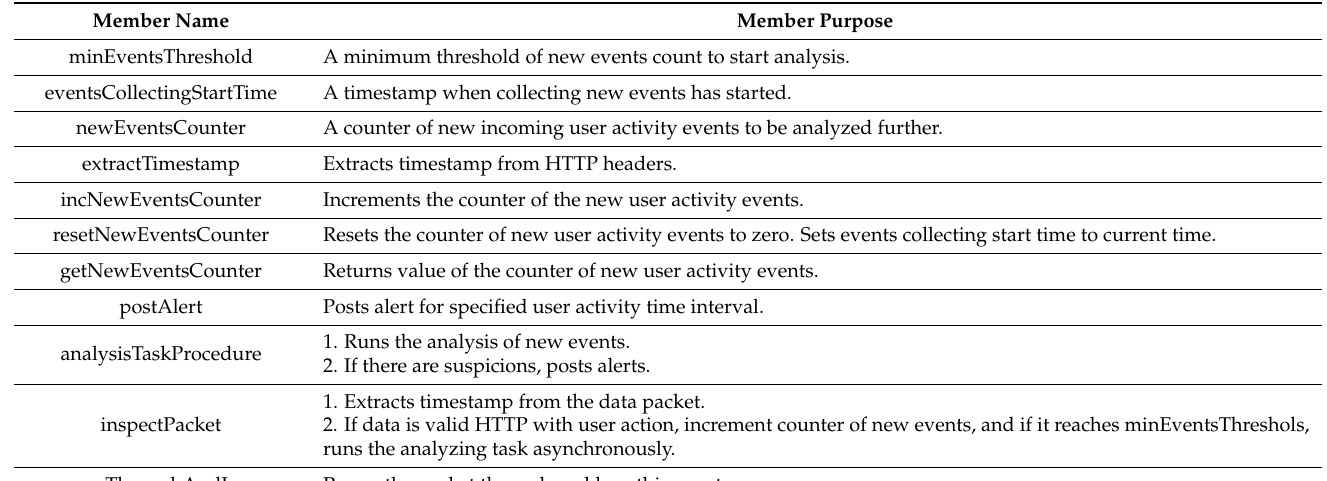
Table A6. Members of HTTPInterceptor class.